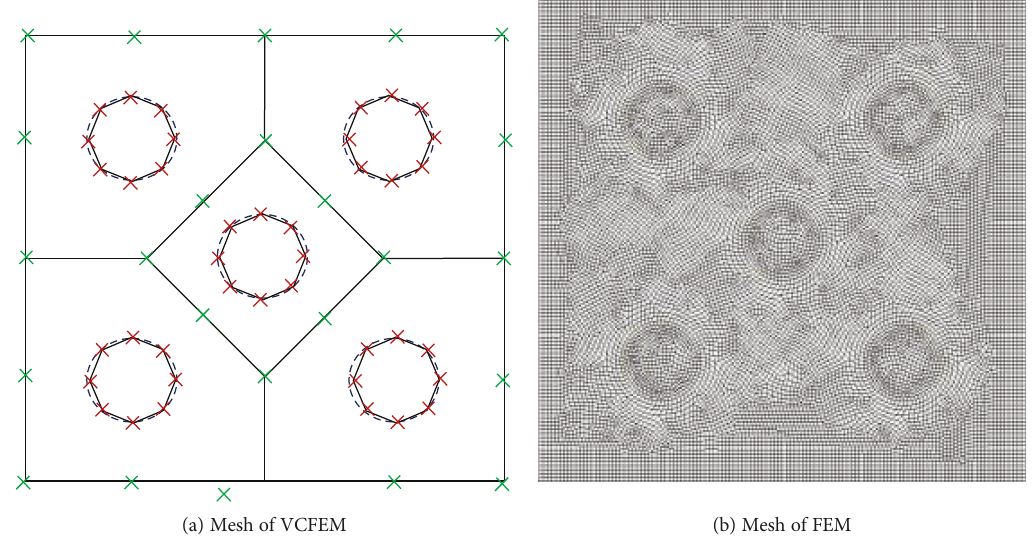
Figure 5: Mesh of two numerical methods. Table 1: Comparison of two methods ’ displacement results in load